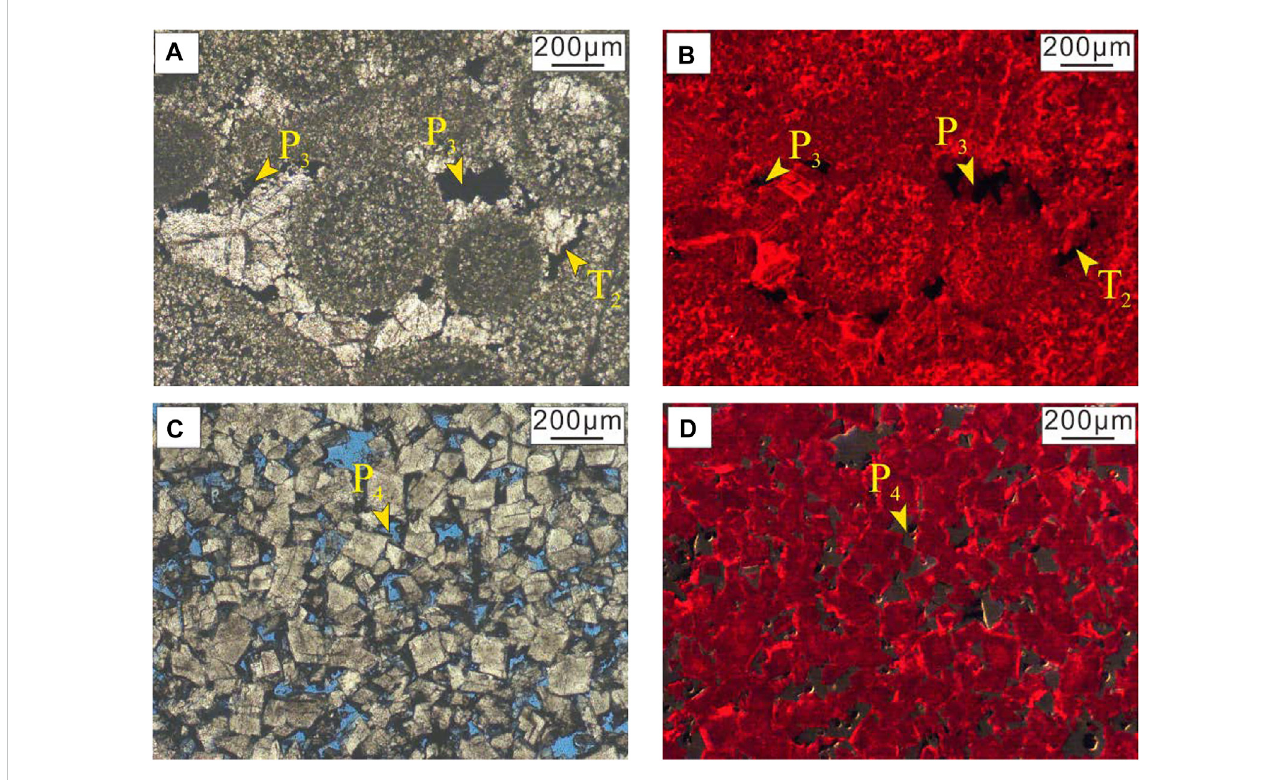
FIGURE 7 CL characteristics of Lithofacies C and D in Feixianguan Formation tight oolitic reservoir.